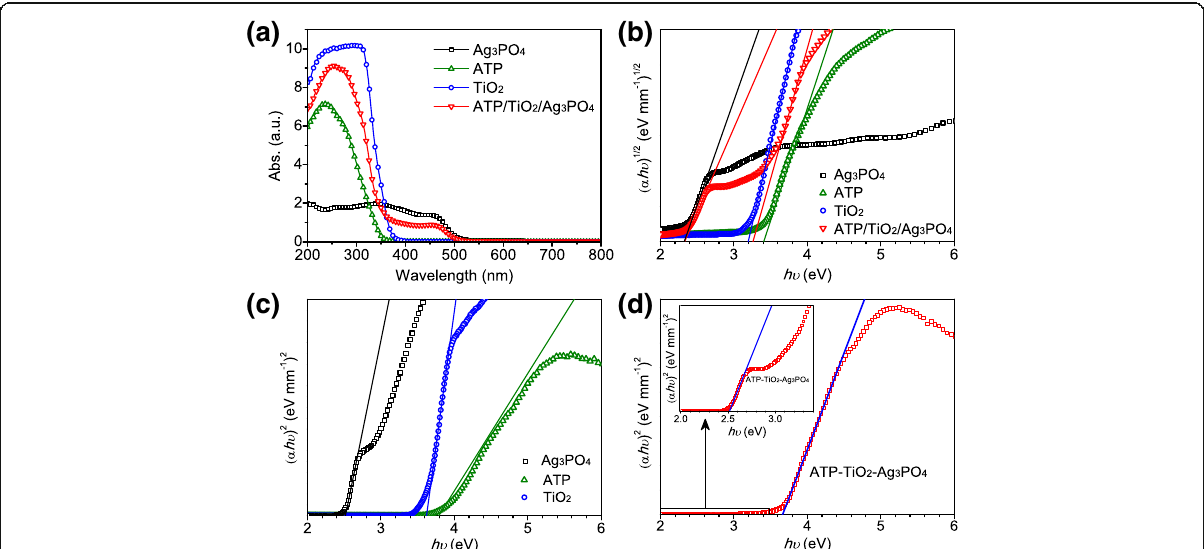
Fig. 3 a UV-vis absorption spectra and b plots of ( α h ν ) 1/2 versus ( h ν ) of Ag 3 PO 4 , ATP, TiO 2 and ATP/TiO 2 /Ag 3 PO 4 ternary nanocomposite; c plots of ( α h ν ) 2 versus ( h ν ) of Ag 3 PO 4 , ATP and TiO 2 ; d plots of ( α h ν ) 2 versus ( h ν ) of ATP/TiO 2 /Ag 3 PO 4 ternary nanocomposite, and the inset in d is the partial enlarged detail of the plots in d